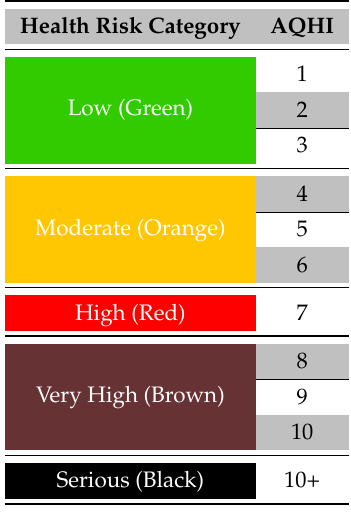
Table 4. Air Quality Health Index (AQHI) of Hong Kong Environmental Protection